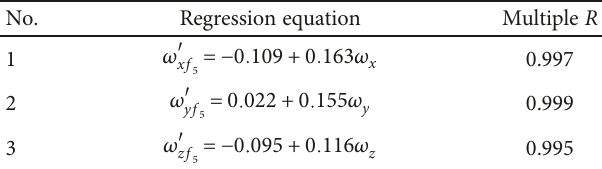
Figure 13: Fitting polynomial and fi tting results of empty storage tank and microsatellite with the deployment mechanism for ω xf ′ , and ω ′ . ω yf 5 zf 5 ′ , ω ′ , and ω ′ of the linear regression equations. Table 19: ω xf 5 yf 5 zf 5